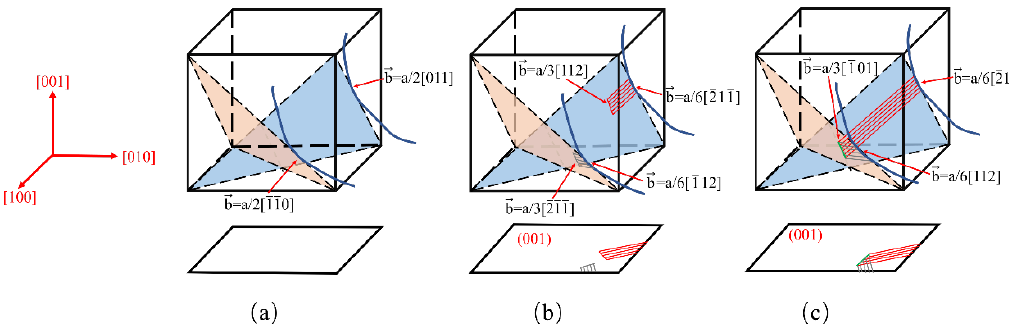
Figure 6. Schematic illustration of ( a ) dislocations moving to the surface of γ/γ′ phases, ( b ) the formation of stacking faults and ( c ) the reactions between stacking faults in the γ′ phase [16].